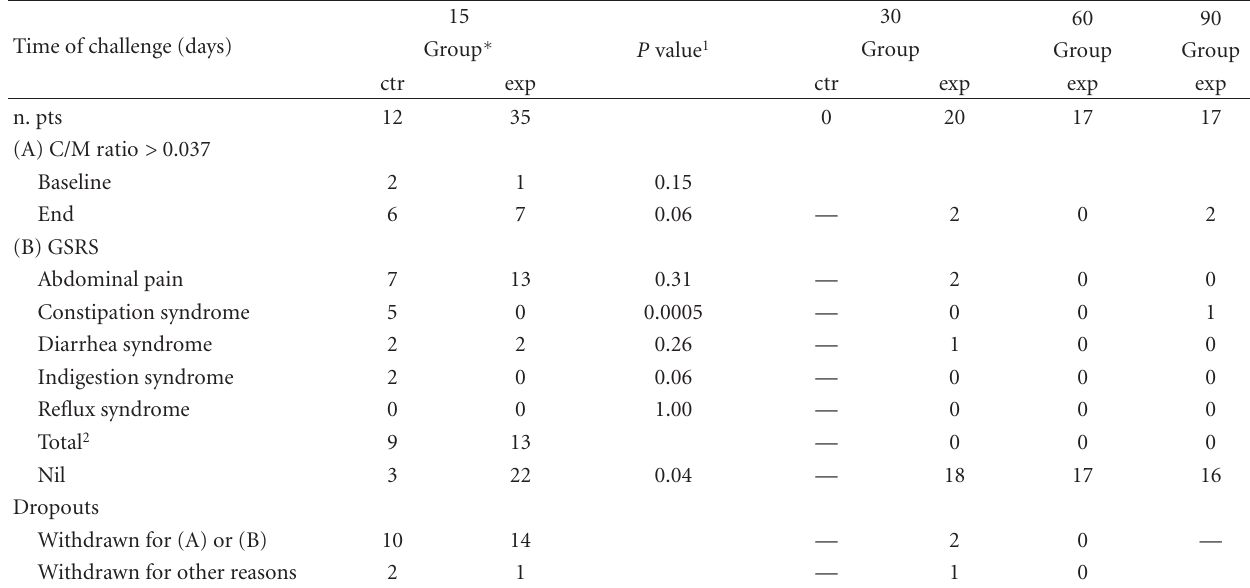
Table 2: K-CH 3 -gluten challenge: clinical and intestinal permeability